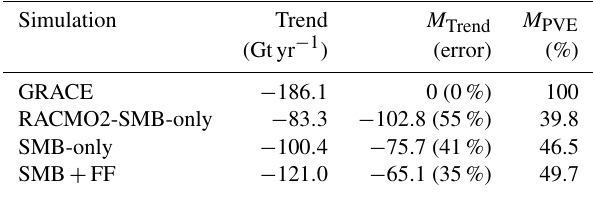
Figure 11. Observed and modeled, cumulative, whole-ice-sheet mass trends obtained using annually averaged ice thickness fields and the spatial smoothing kernel from Fig. 10.